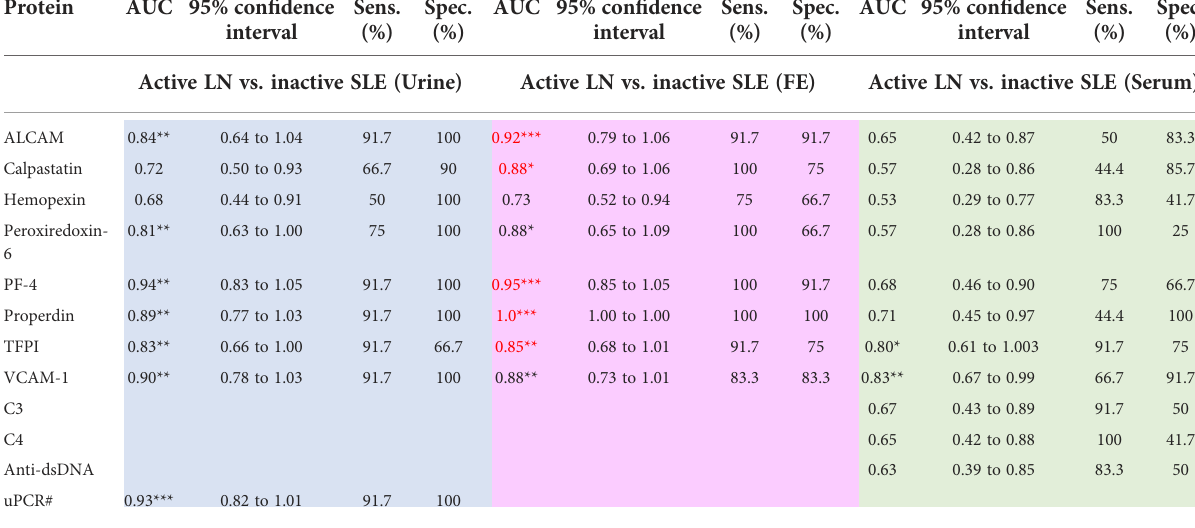
TABLE 3 Diagnostic performance of serum, urine, and fractional excretion of biomarkers in active LN vs. inactive SLE. Protein